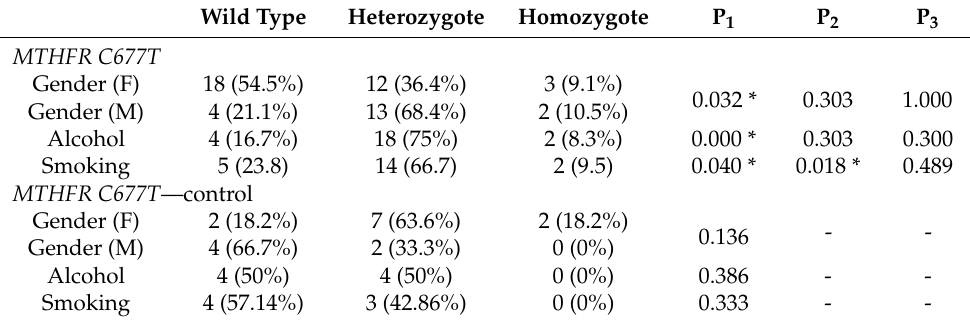
Table 5. MTHFR C677T and cardiovascular risk